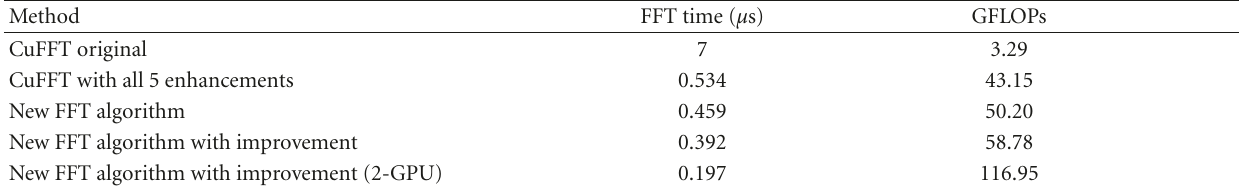
Table 6: Performance summary of CuFFT, proposed methods to improve it and the new FFT